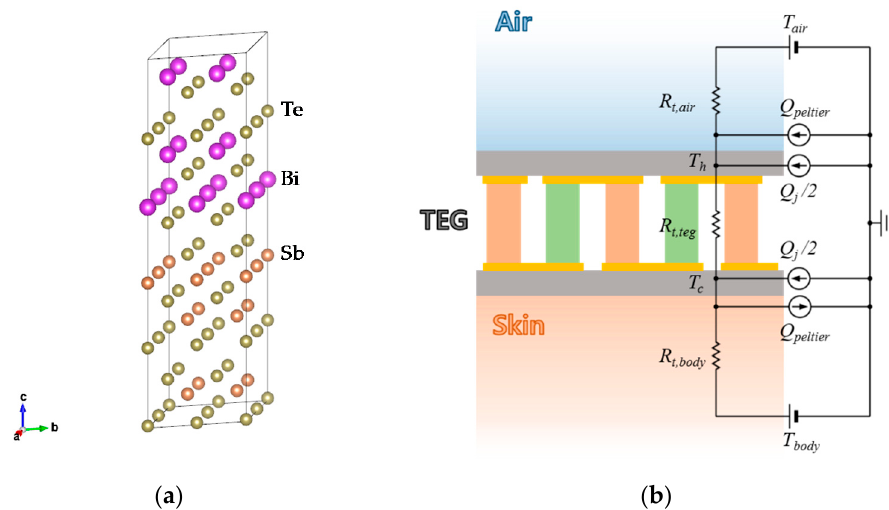
Figure 1. ( a ) Crystal structure of P-type BiSbTe 3 ( b ) Thermal resistance model of the human body application. Peltier effect and load matching were considered. R t,air , R t,teg , and R t,body are thermal resistances of air, thermoelectric generator (TEG), and body, respectively. T air is ambient temperature and T body is core temperature of the body. Q j is Joule heat generated by current through the device, and Q peltier is heat flux generated by the Peltier effect.